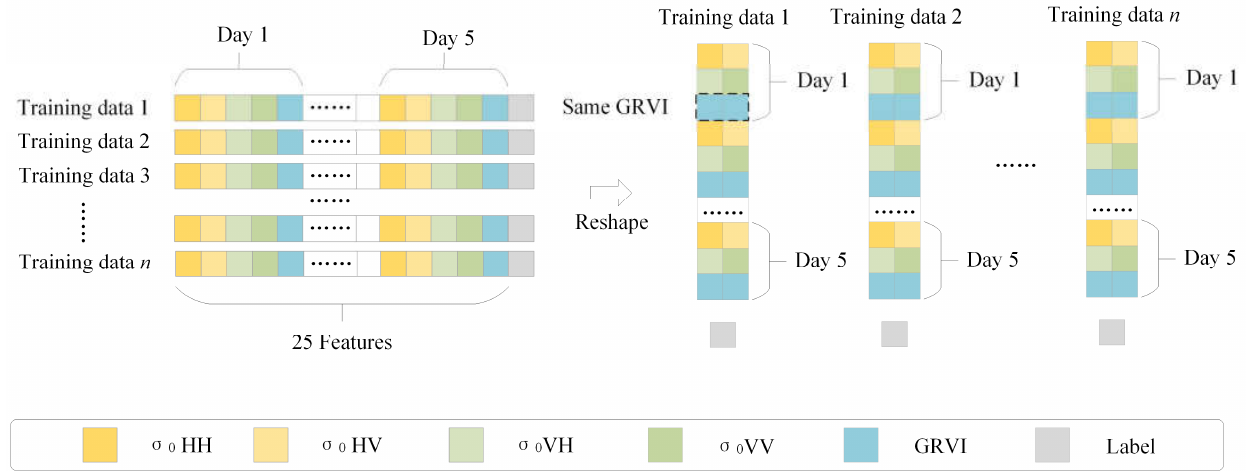
Figure 3. Backscattering coefficient and GRVI reshaping.